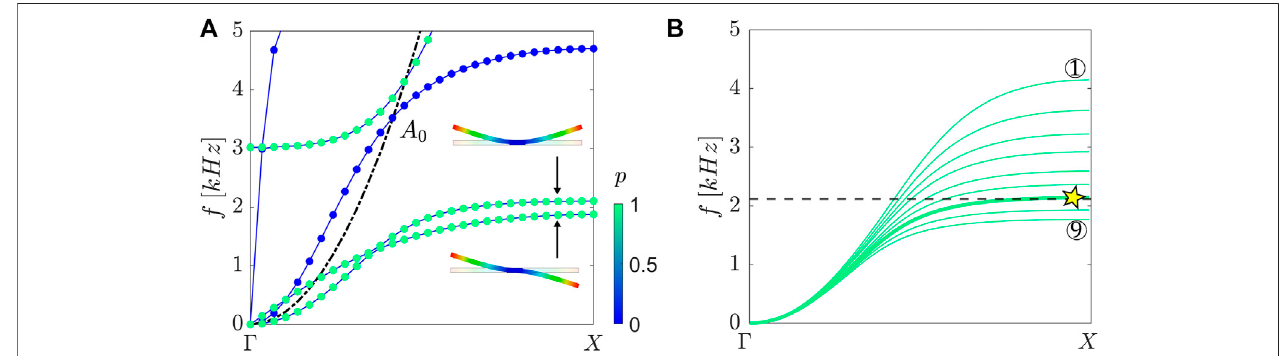
FIGURE2 | (A) Numerical dispersion curves for aperiodic array ofidentical resonators of fi xed length (here wetake the resonator having length 25 mm that isthen endowed with piezoelectric patches in the graded wedge); scatter points colours represent the wave polarization (green corresponding to the vertical motion, i.e. bendingoftheresonator). (B) In-phasebendingmodefordifferentresonatorsinsidethearray.Movingfromshort (Pendry, 2000)tolong(Pennecetal.,2011)resonators at a given frequency the group velocity and the wavelength decrease, until the bandgap opening (here denoted with a yellow star in the position of the resonator number (Vasseur et al.,